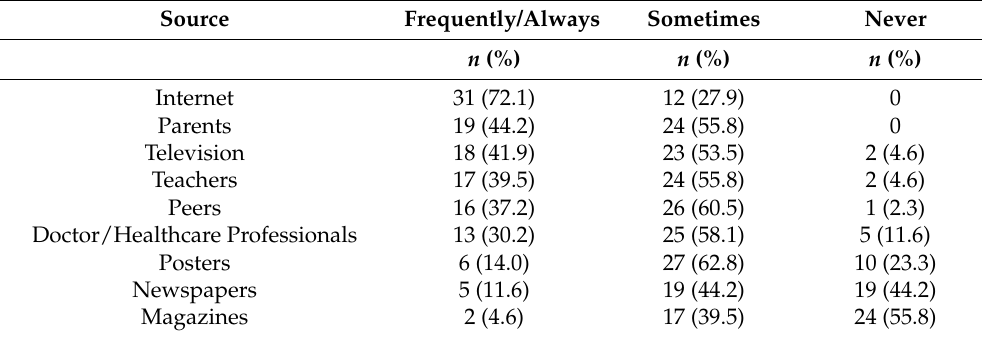
Table 2. Source of reference for health information among adolescents in needs assessments ( n =